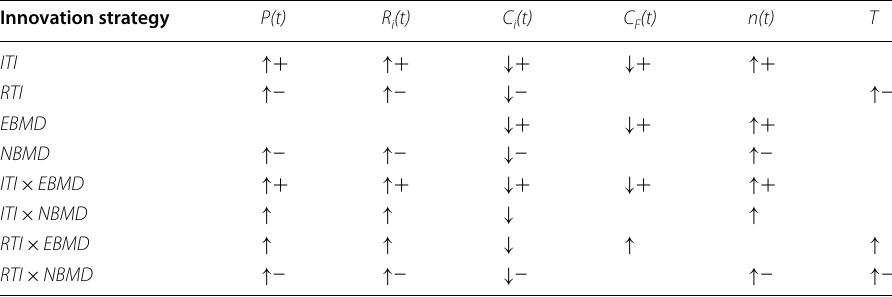
“ ” and “ ” indicate the elevated or reductive effect of innovation on trading factors, and “ ↑ ↓ moderating effect of scale